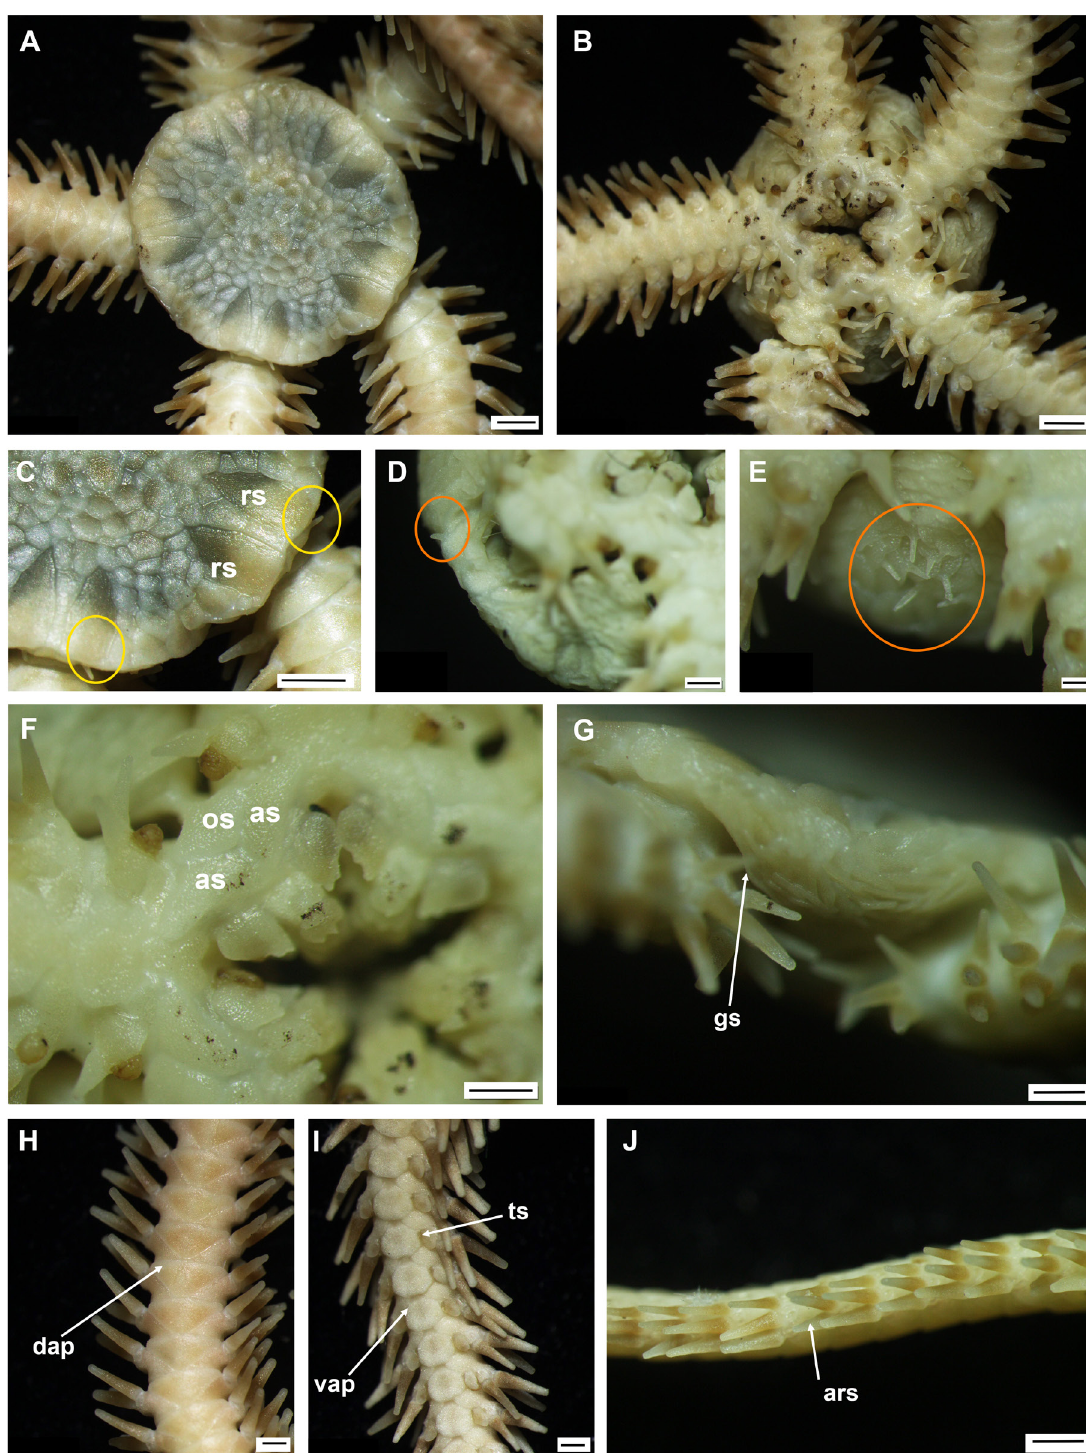
Fig. 36. Ophiactis cf. perplexa Koehler, 1897 (A–D, F–J = IDSSE EEB-SW0013; E = IDSSE EEB- SW0014). A . Dorsal disc. B . Ventral disc. C . Radial shields (disc spines below radial shields highlighted). D–E . Disc spines on ventral disc. F . Oral frame. G . Lateral disc. H . Dorsal arm. I . Ventral arm. J . Lateral arm. Abbreviations: ars = arm spine; as = adoral shield; dap = dorsal arm plate; gs = genital slit; os = oral shield; rs = radial shield; ts = tentacle scale; vap = ventral arm plate. Scale bars: A–C, E, J = 1 mm; D = 200 µm; F–I = 500